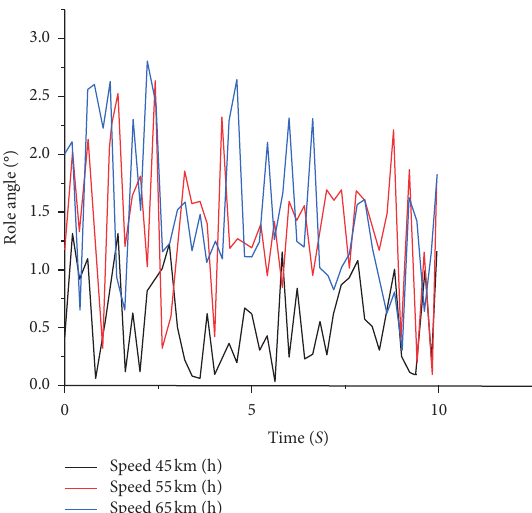
Figure 12: Roll angle change of the uniform motion lane changing scenarios.